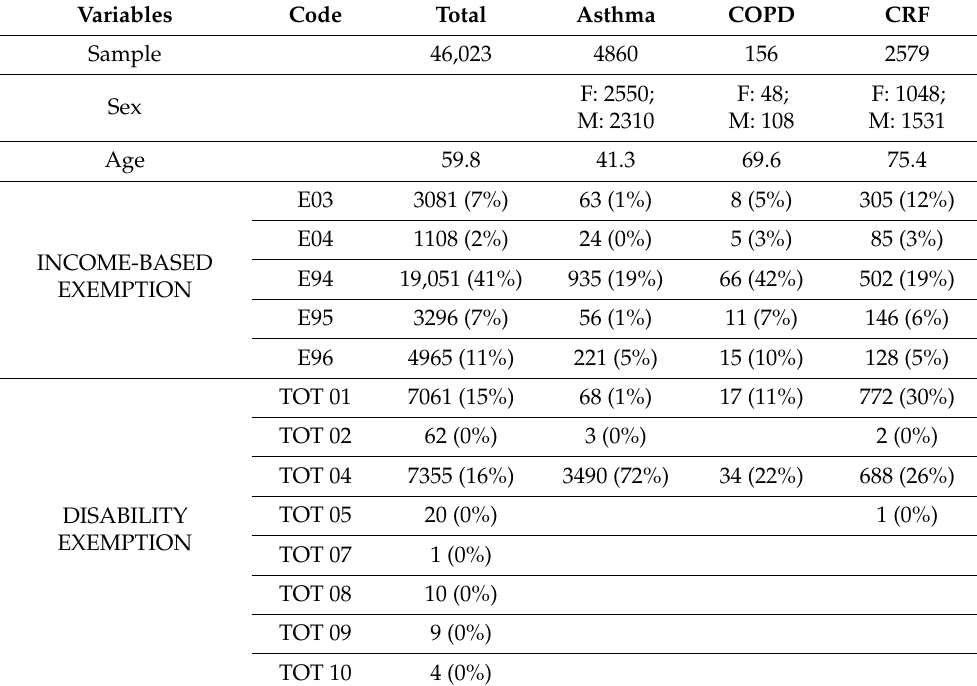
Table 3. Stratification of the sample with chronic respiratory diseases (CRDs) and sub-classes of asthma, chronic obstructive pulmonary disease (COPD) and chronic respiratory failure (CRF) by income and disability exemption code. Variables